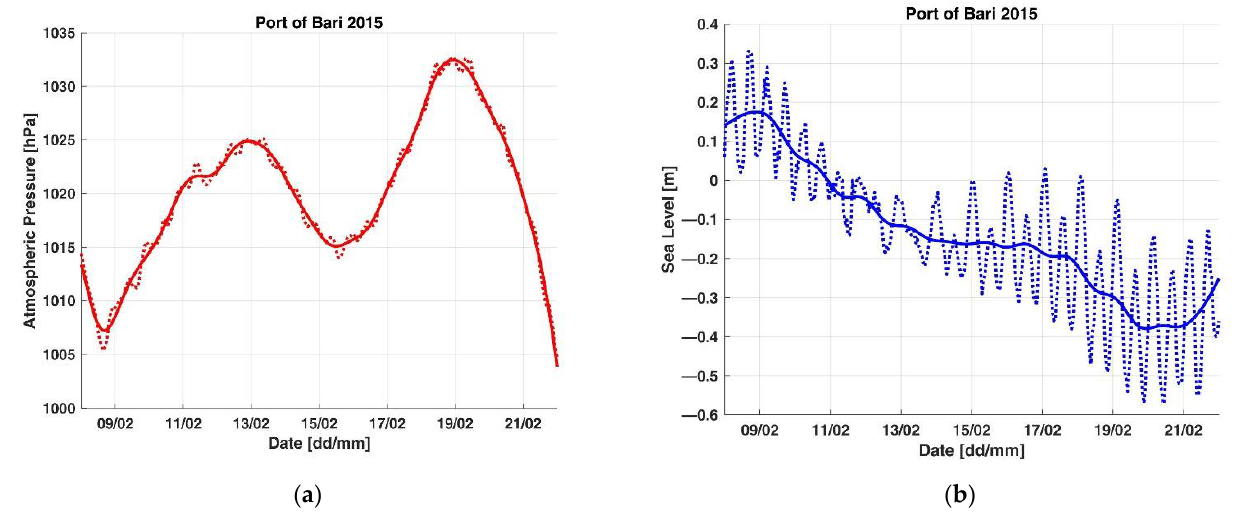
Figure A17. Low-frequency components of meteo-mareographic parameters acquired by ISPRA’s monitoring station in the port of Bari from 8 to 22 February 2015: ( a ) atmospheric pressure; ( b ) sea level.